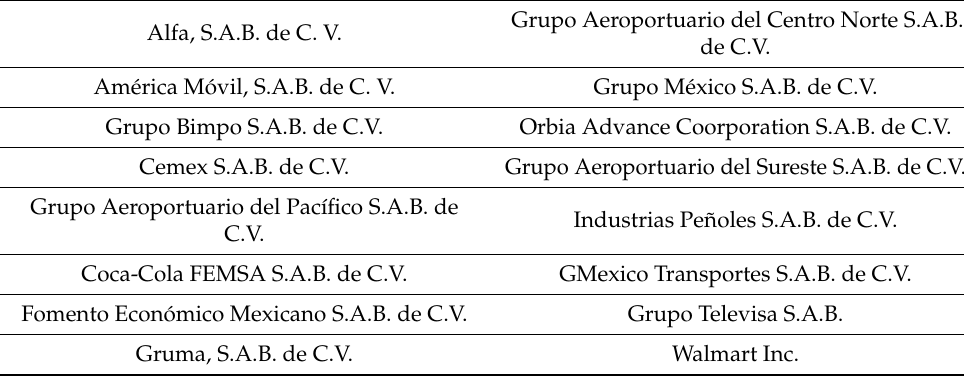
Table 1. Stocks considered for the European call